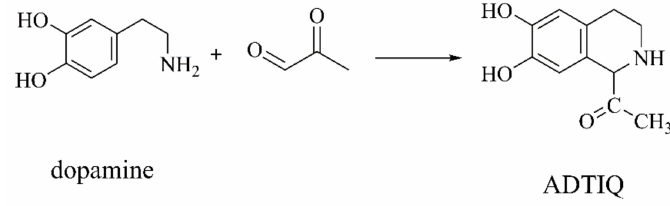
Figure 6. The biosynthesis of ADTIQ [58].